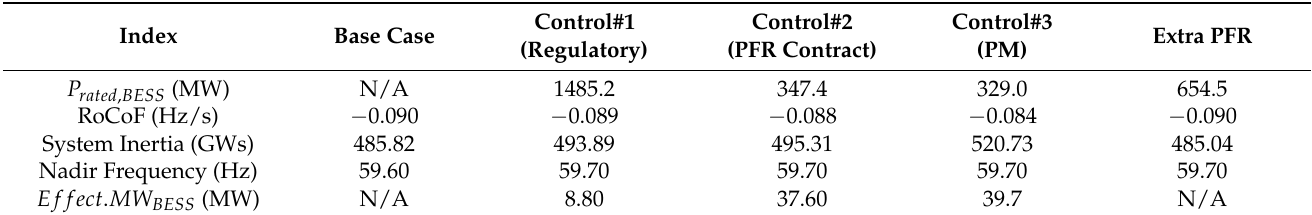
Figure 8. Frequency dynamic characteristics under critical conditions by control method of BESS. Table 3. Effect analysis according to evaluation index by frequency response control method of BESS.